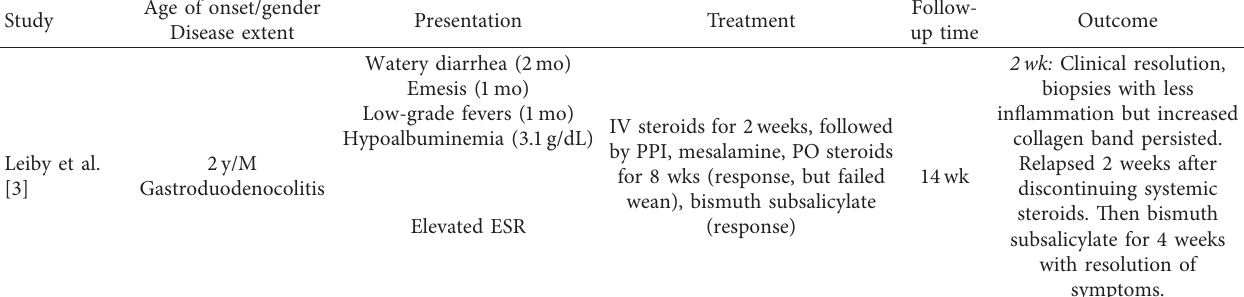
Table 1: Cases of pediatric collagenous gastroenterocolitis reported in the